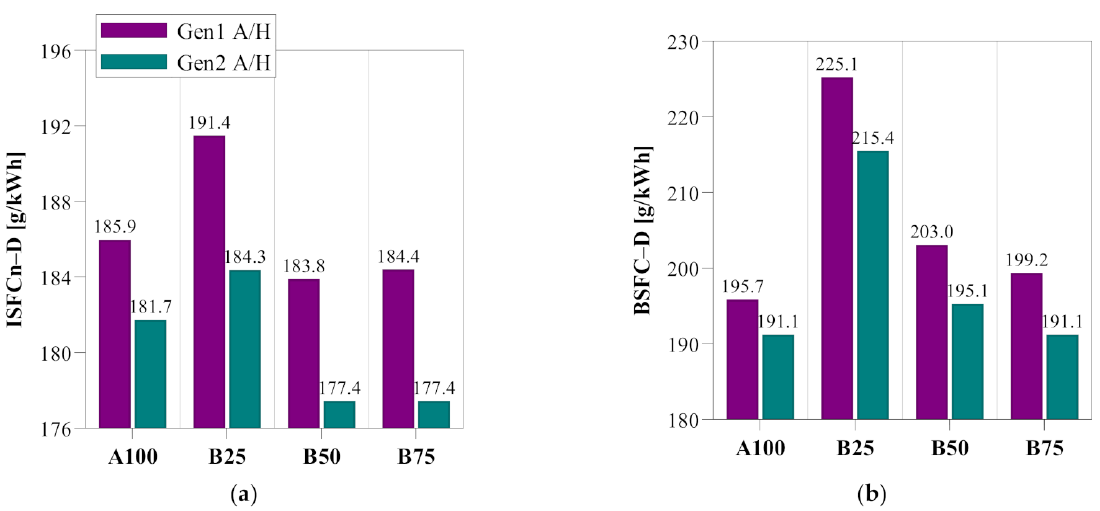
Figure 20. Comparison of fuel efficiency results between Gen1 A/H and Gen2 A/H: ( a ) ISFCn-D; ( b )